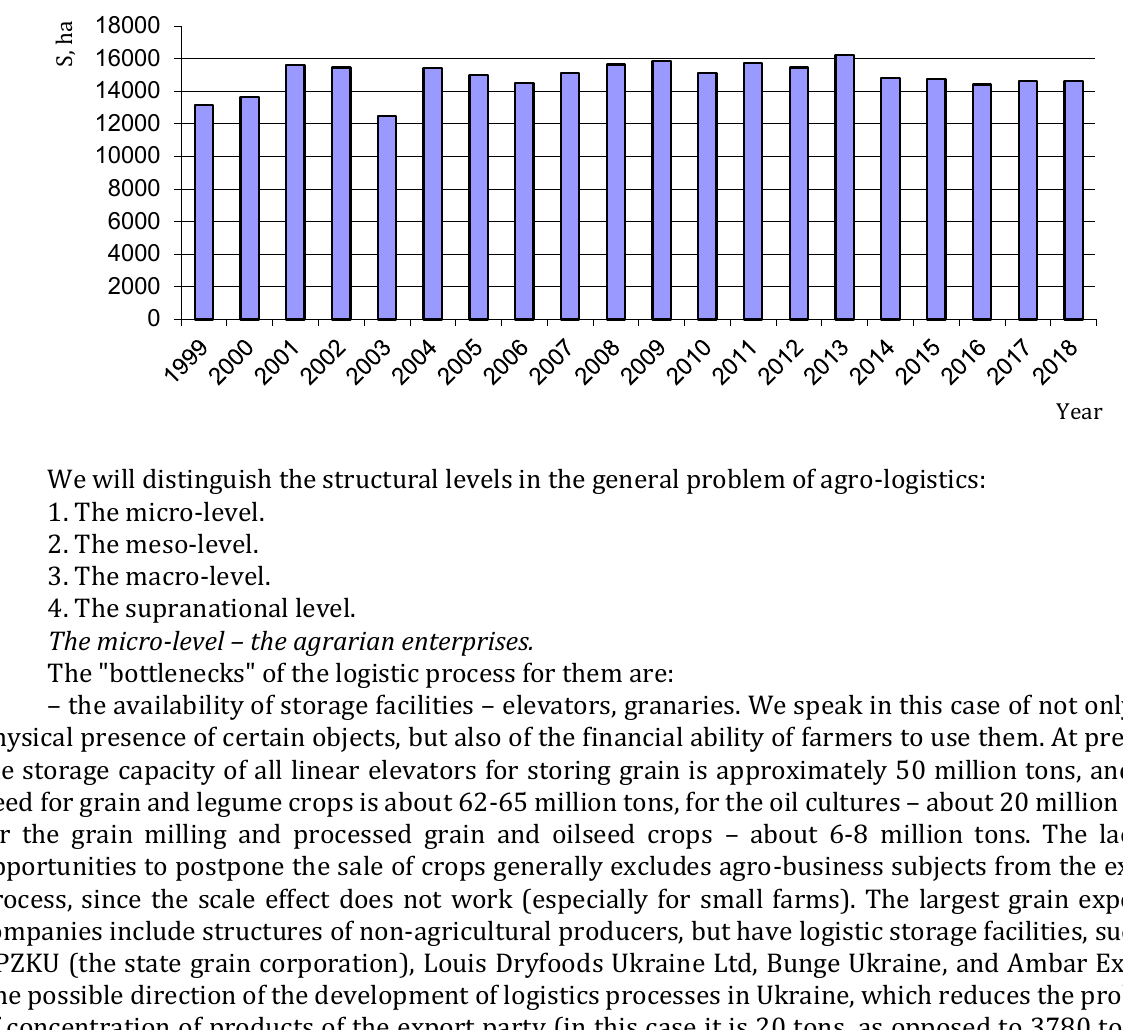
Figure 2: The dynamics of areas under grain crops and legumes in Ukraine in